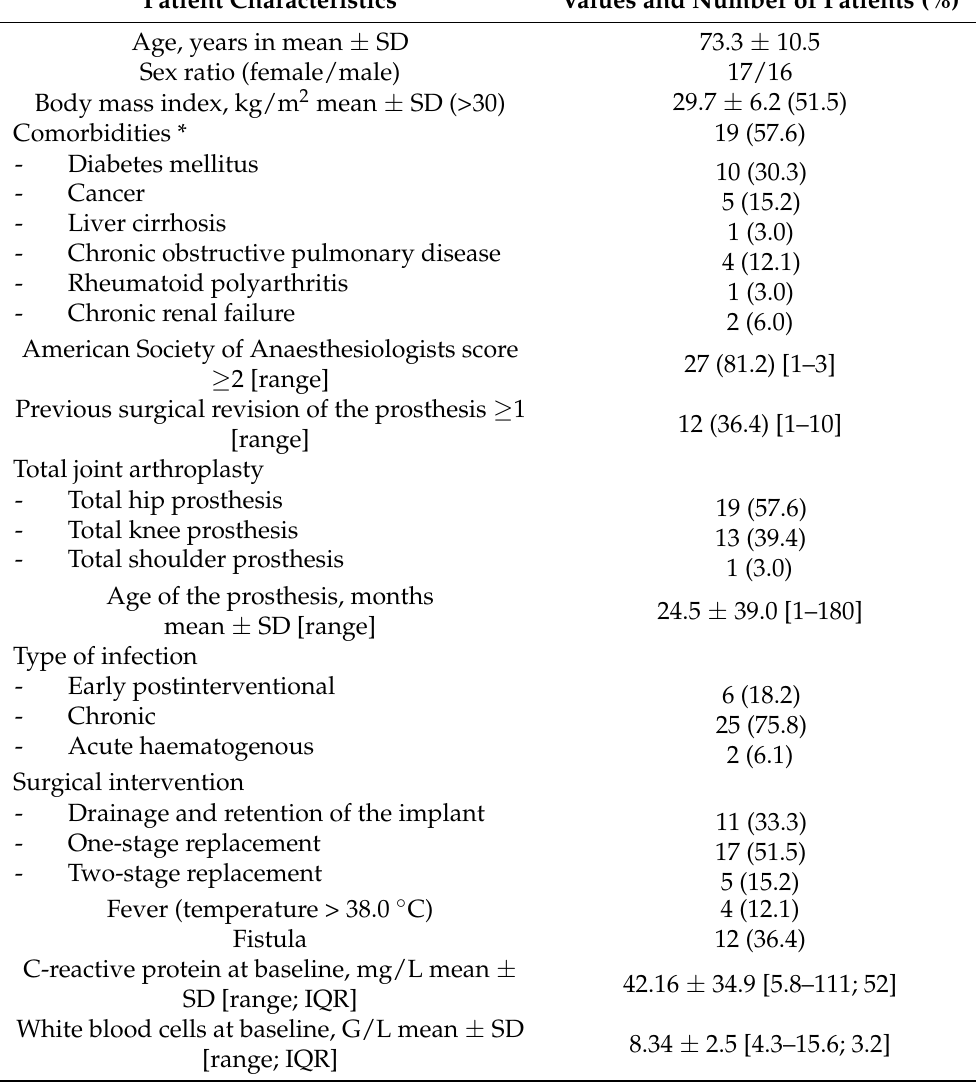
Table 1. Demographic data of 33 patients with periprosthetic joint